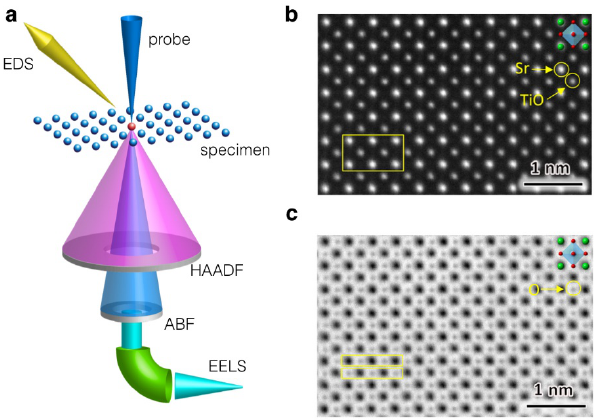
Figure 18. ( a ) Schematic view of ray-path of scanning transmission electron microscopy (STEM) mode and detector geometry of high-angle annular dark-field (HAADF), annular bright-field (ABF), electron-energy loss spectroscopy (EELS) and EDS. Simultaneously recorded ( b ) HAADF and ( c ) ABF STEM images of SrTiO 3 viewed along the [001] orientation.